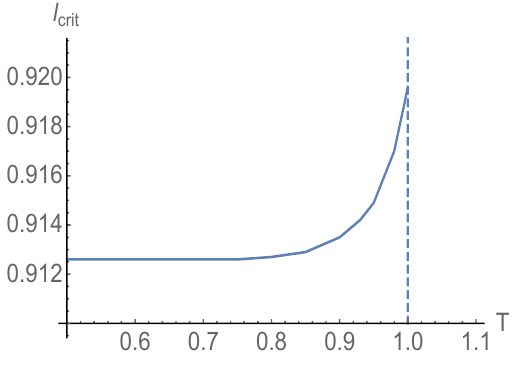
Figure 28 . ‘ c vs T in the specious-con(cid:12)ned phase at (cid:22) = 0. This ( T; ‘ c ) holographic phase diagram can be compared with the SU(2) lat- tice gauge theory conjecture of [44], (cid:12)gure 8. In units